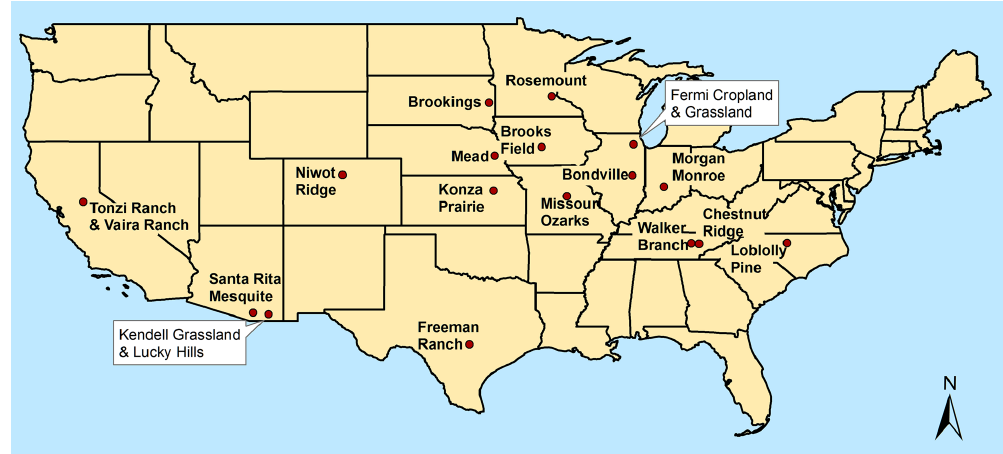
Figure 1. Map showing the location of the Ameriflux sites used in this study. Table 1. Summary of Ameriflux sites used in this